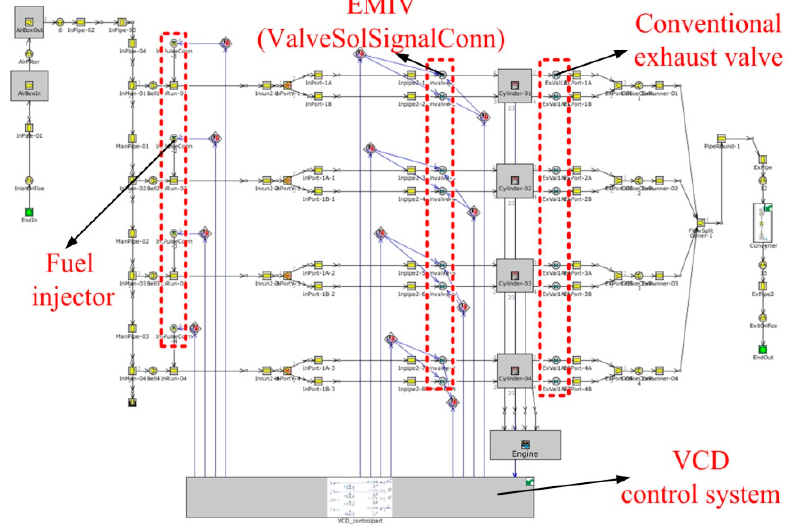
Figure 9. 1D model with EMIV.